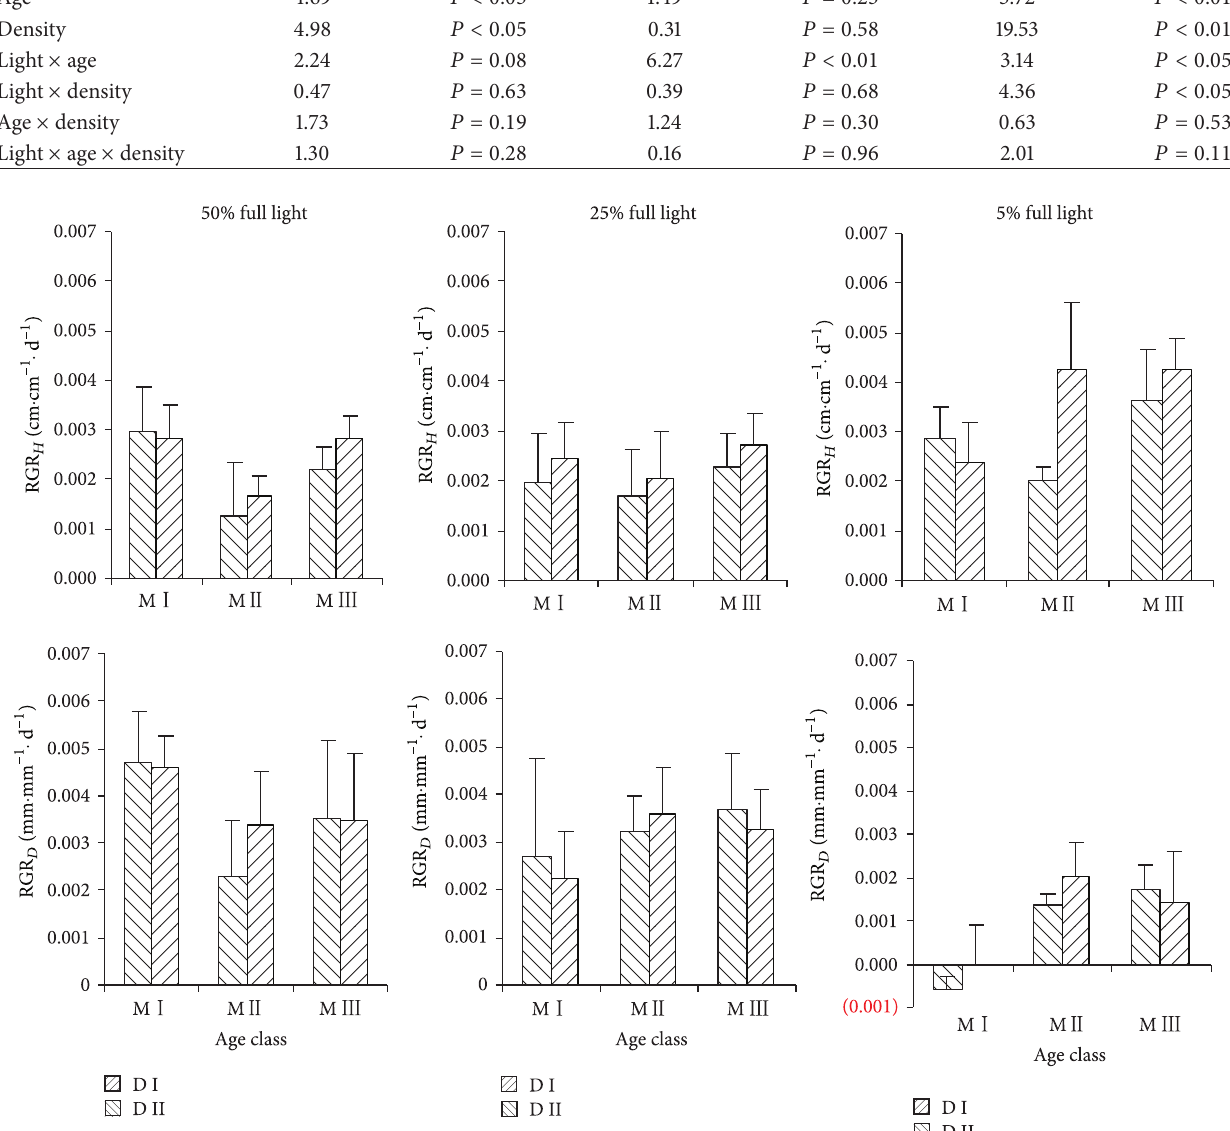
Figure 3: Effects of age and stand density of mother tree on seedling